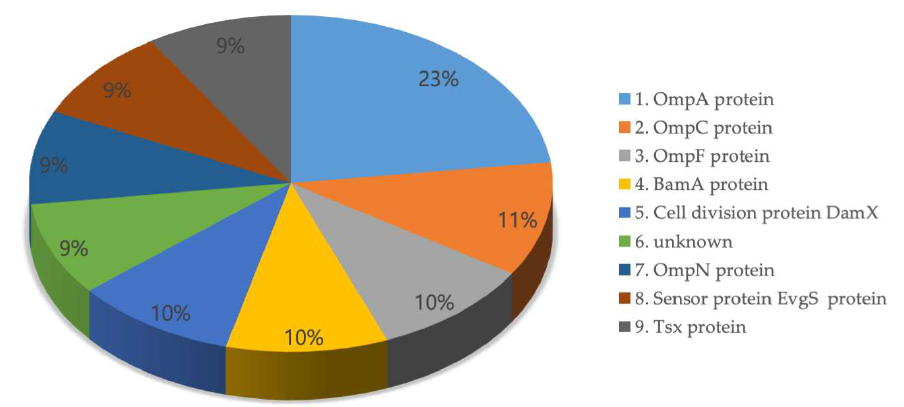
Figure 3. The most common interacting proteins of the outer-membrane-embedded proteins. The protein–protein interaction (PPI) information was obtained from the String database (version 11.0) [35].